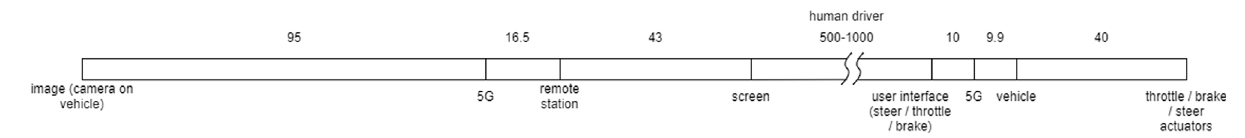
Frontiers in Future Transportation |